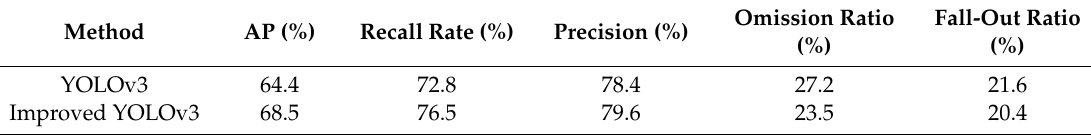
Figure 13. Detection examples for the CAR dataset: ( a ) Example 1; ( b ) Example 2. Table 9. Verification results for